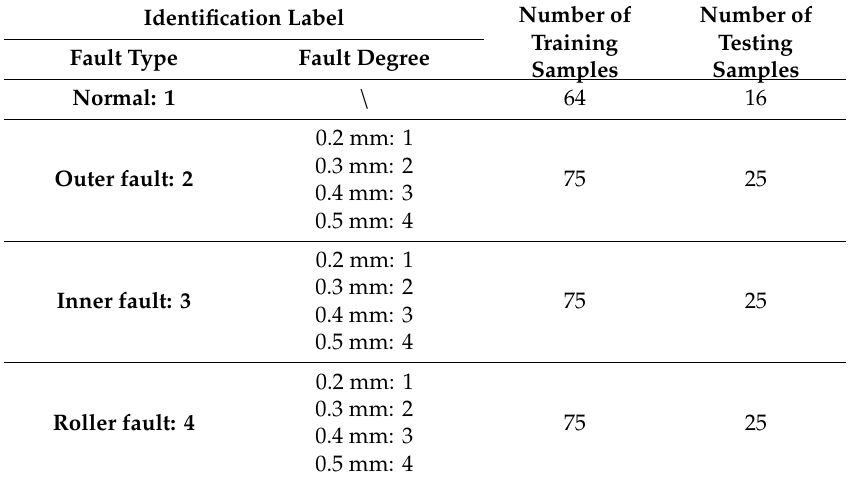
Table 2. Description of dataset for hierarchical fault diagnosis model.